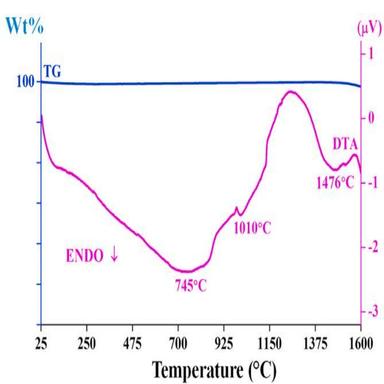
TG/DTA curves and Curie temperature of Yb1.98Lu0.02Sn2O7.